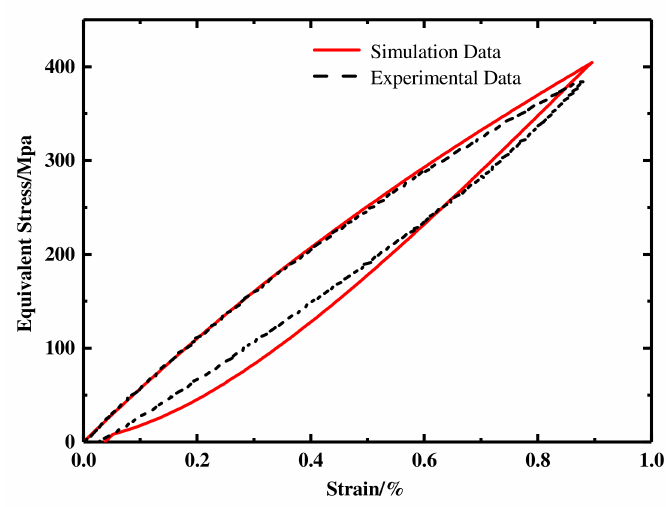
Figure 15. Simulation and experimental results of uniaxial loading and unloading.